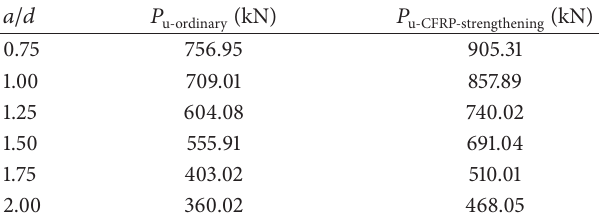
Table 2: Ultimate shear strength of RC deep